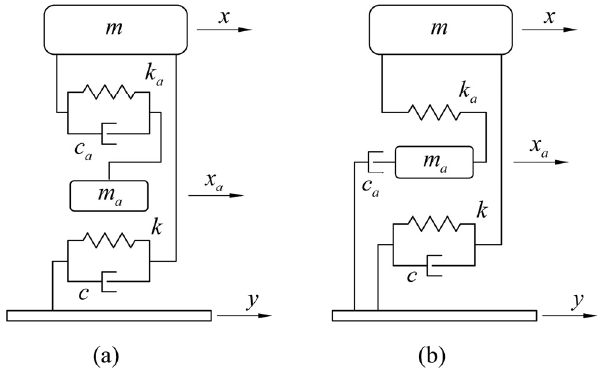
Figure 1. Two configurations of TMD: ( a ) model A; ( b ) model B.